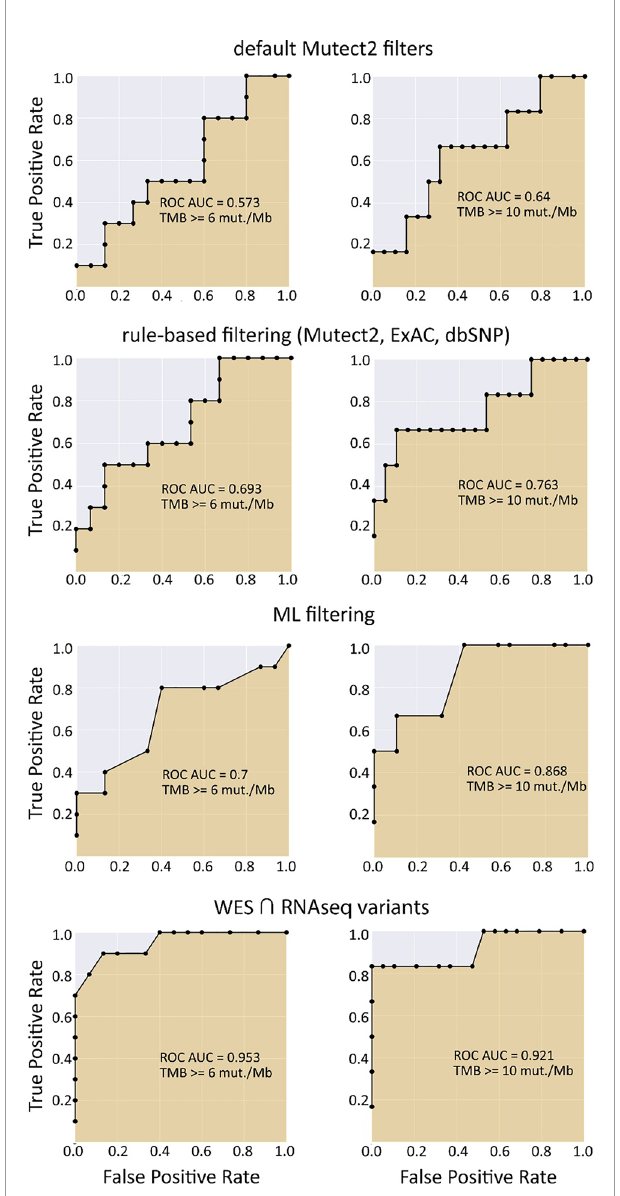
FIGURE 6 | ROC AUC scores for predicting WES-TMB per megabase with RNAseq-TMB per megabase (TCGA FFPE dataset, n = 26, no matched norm was used for mutation calling in WES).